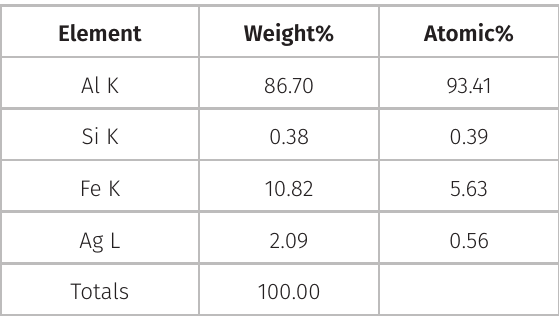
Table II. EDX analysis of the first coating layer.